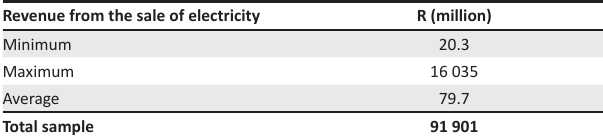
TABLE 6: Summary of revenue from the sale of electricity.